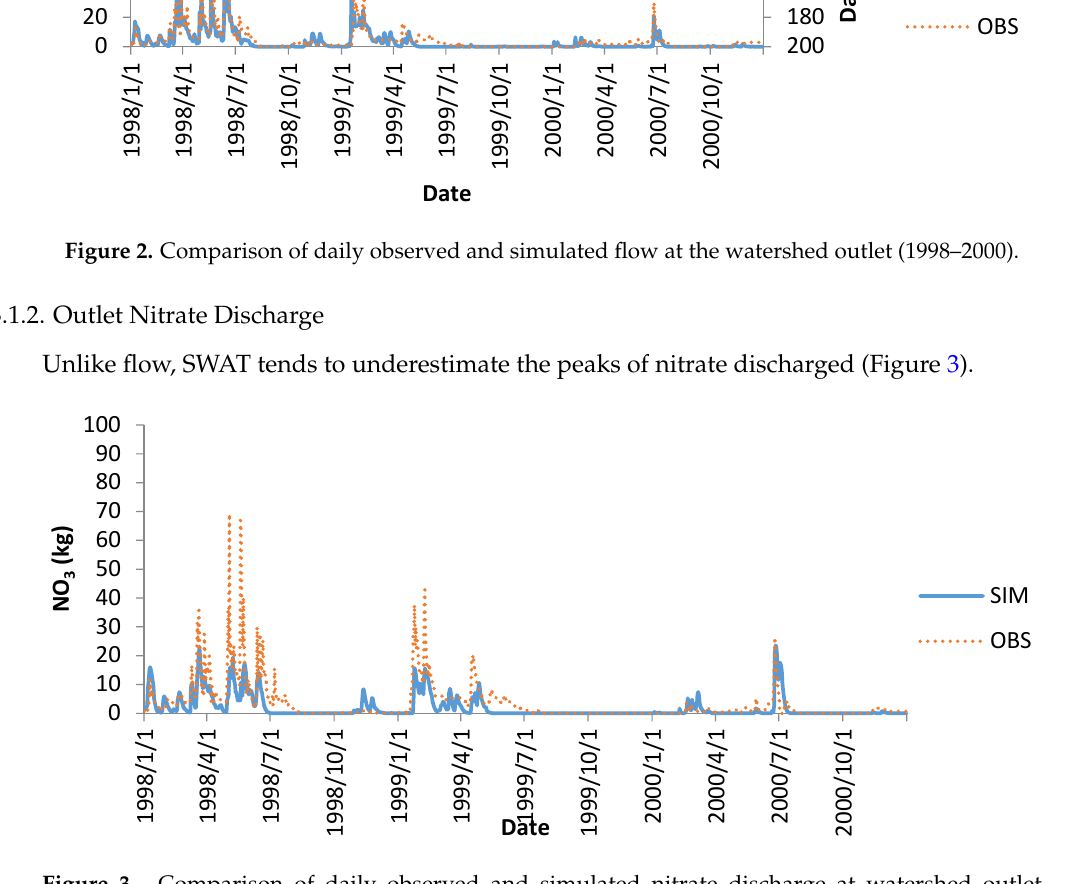
Table 2. Yearly Wilcoxon p-values.